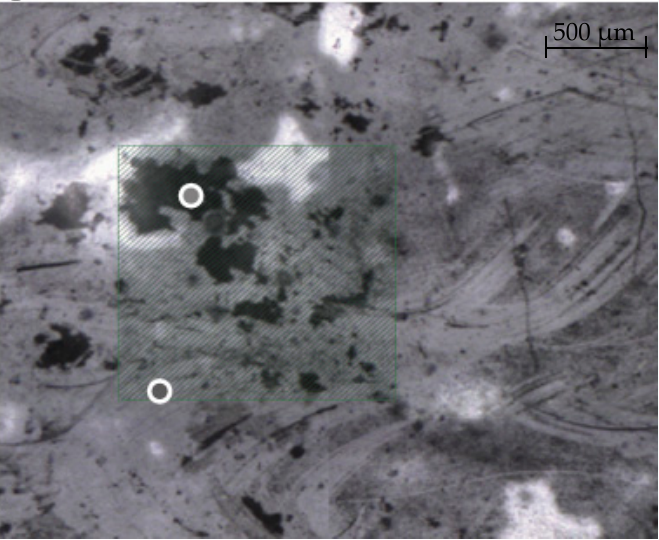
Figure 9. Internal Surface Mapping of PA/LDPE Multilayer Film. The square zone highlighted in Figure 10 is the automatic ATR mapping region. To determine the betulin distribution in the PE layer, automatic integration was performed under the peak in the region of 880 cm − 1 [72].